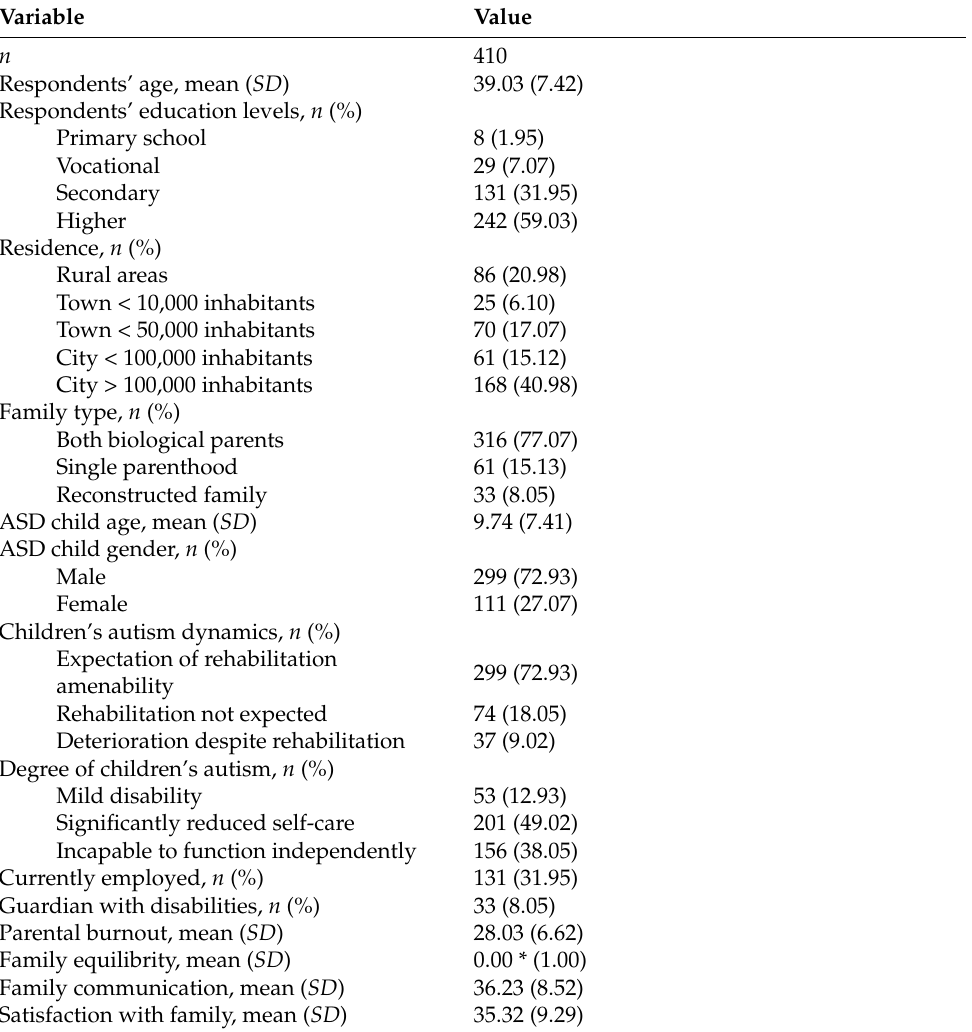
Table 1. Respondents’